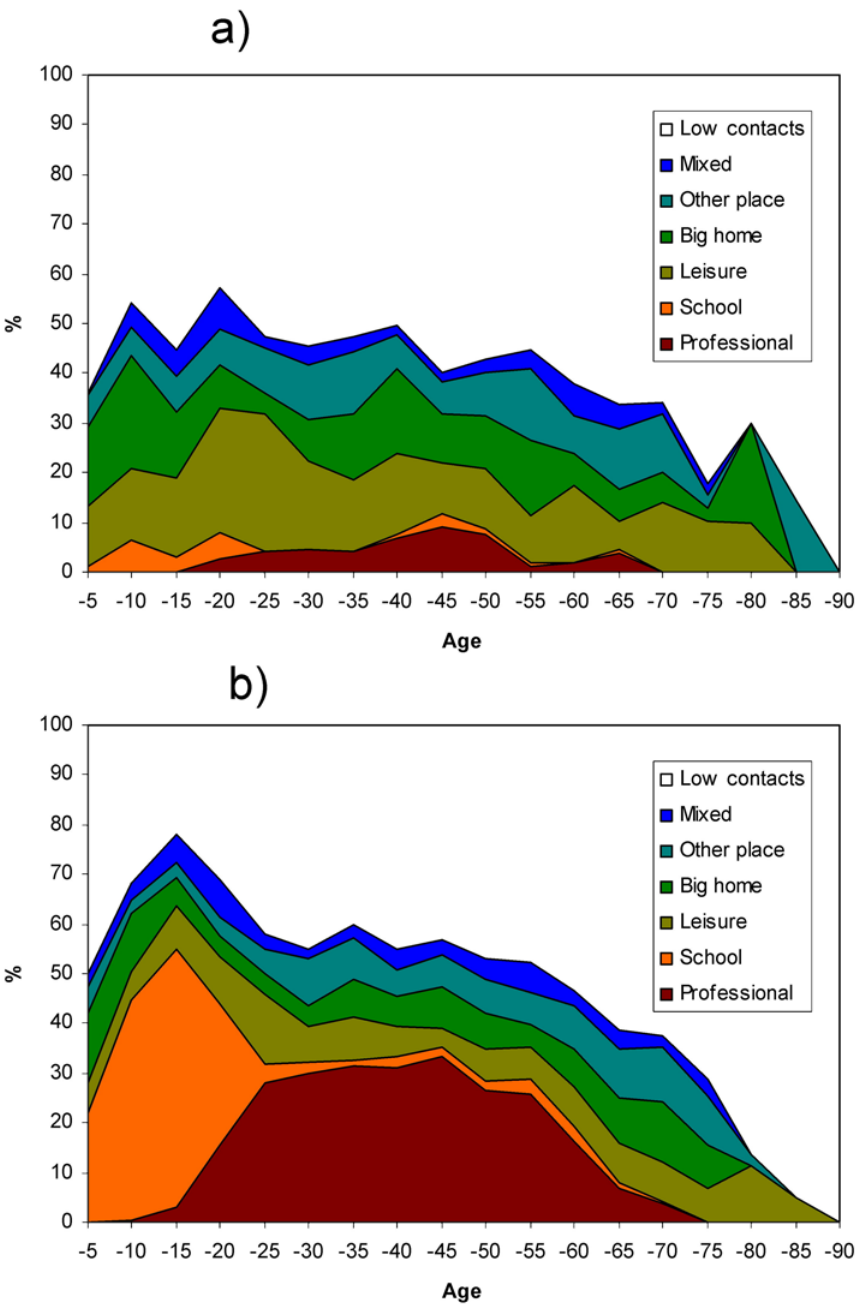
Figure 3. Distribution of contact profiles by age and weekdays (%). a) weekend. b) weekday.